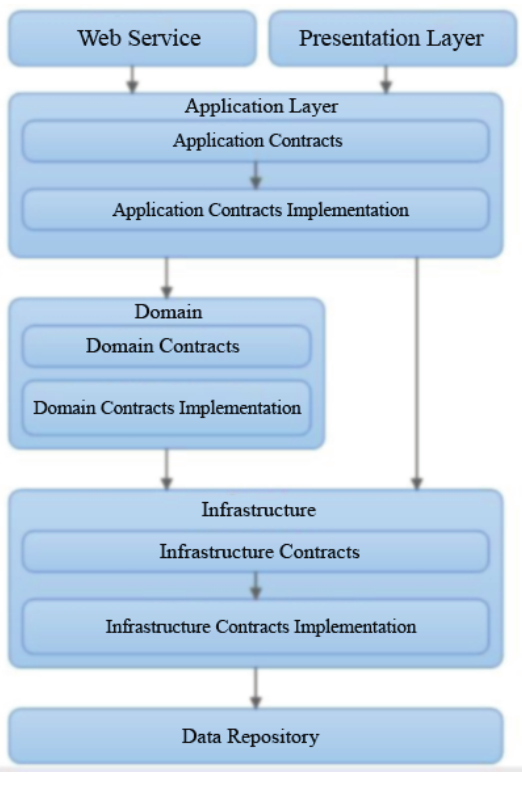
Figure 3: GITIRBio High Level